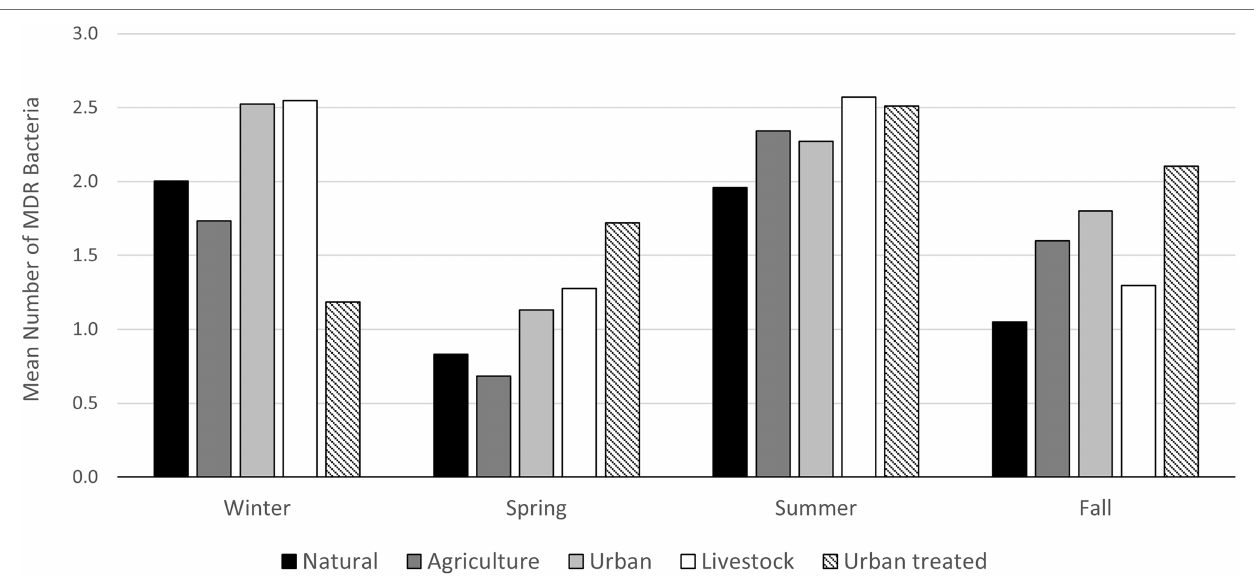
FIGURE 7 | Mean number of environmental MDR bacteria by land use and season. Isolates resistant to three or more antimicrobial classes were cataloged as MDR following previously standardized criteria (Magiorakos et al.,